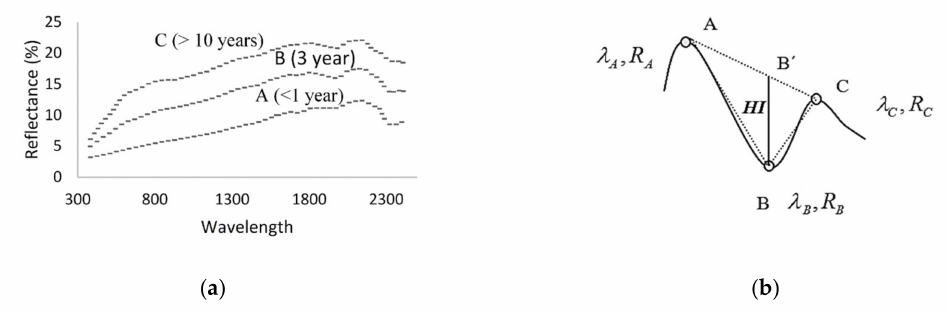
Figure 3. ( a ) Asphalt signature of di ff erent ages [11], ( b ) hydrocarbon index, and stands for wavelength and radiance values, respectively